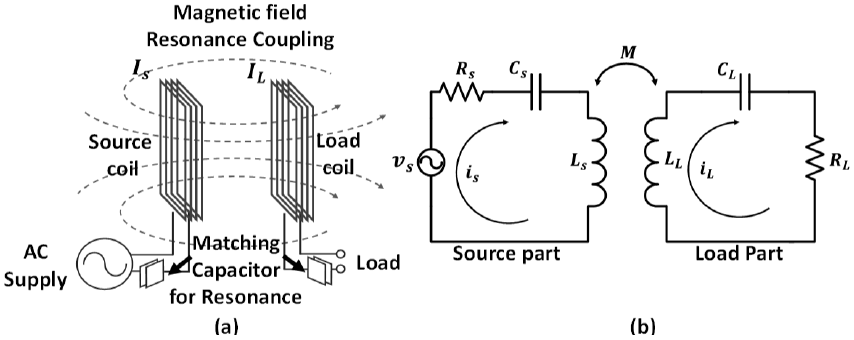
Figure 1. Concept of the WPT system: ( a ) the WPT mechanism and ( b ) equivalent circuit model.